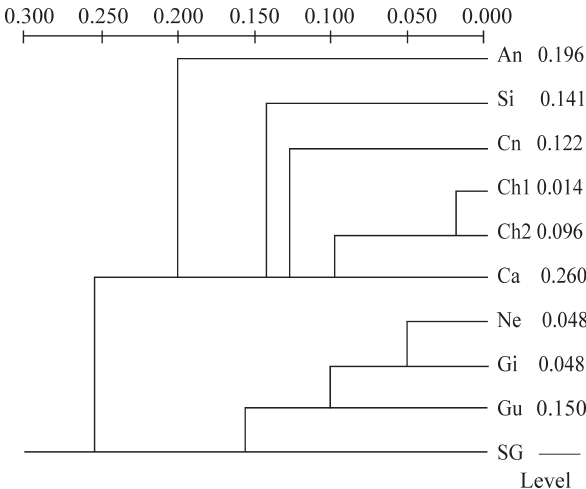
Figure 1 - Dendrogram obtained based on the UPGMA clustering of Nei’s(1978)geneticdistances.An-AberdeenAngus,Si-Simmental,Ch1 - Charolais pop 1 (Garcia, 2001), Ch2 - Charolais pop 2 (Regitano et al. 2000b), Ca - Caracu, Cn - Canchim, Ne - Nelore, Gi - Gyr, Gu - Guzerath, SG - Santa